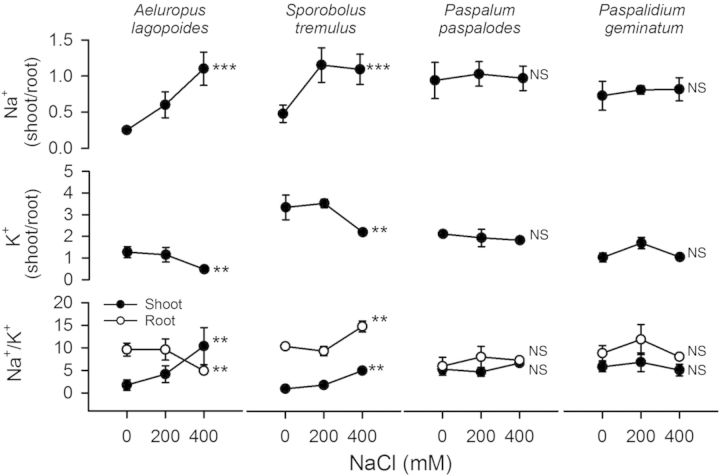
Shoot/root ratios of Na+ and K+ and Na+/K+ ratios of the salt-excreting (A. lagopoides, S. tremulus) and non-excreting (P. paspalodes, P. geminatum) grasses grown under increasing salinity treatments (0, 200 and 400 mM NaCl). Symbols indicate means (±SE) at each salinity level (n = 3). Asterisks (** and ***) represent significant differences among cation contents at P < 0.01 and 0.001 respectively; NS indicates non-significant differences among salinity treatment by one-way ANOVA.